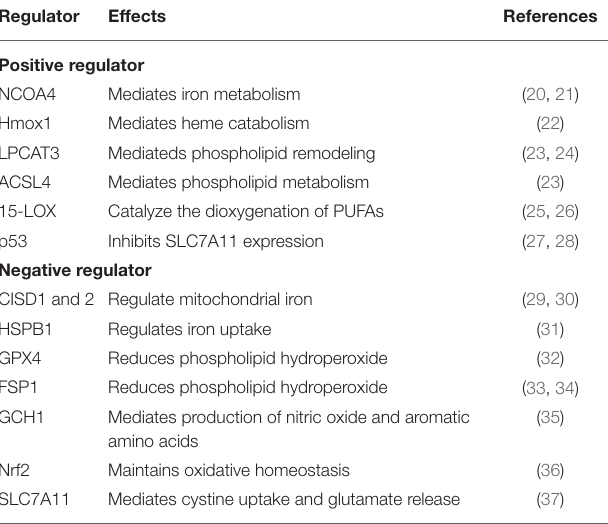
TABLE 2 | Factors involved in ferroptosis